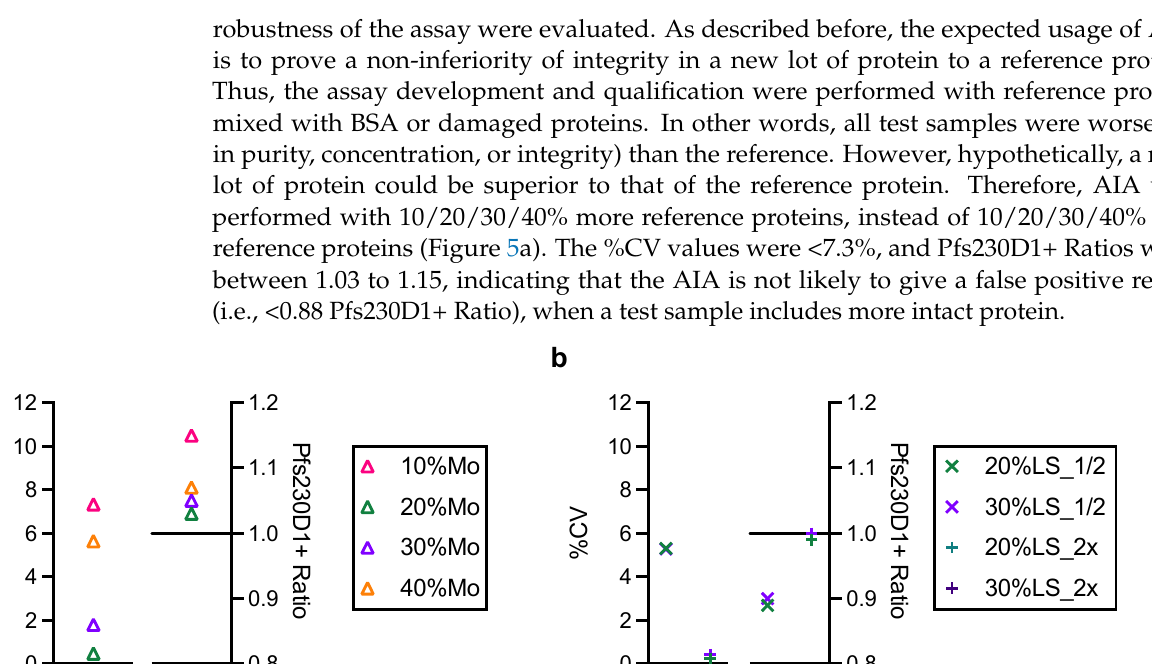
Figure 5. Robustness of assay. ( a ) AIA was performed with 10%, 20%, 30% or 40% more reference Pfs230D1+ proteins (10%Mo, 20%Mo, 30%Mo or 40%Mo, respectively) in test wells. Left-side panel shows %CV in triplicate wells and right-side panel for Pfs230D1+ Ratio. ( b ) AIA was performed with half (20%LS_1/2 or 30%LS_1/2) or double (20%LS_2x or 30%LS_2x) concentration of H18-HRP mAb using 20%LS and 30%LS samples with BSA. %CV for 20%LS_1/2 and 30%LS_1/2 were both 5.3, thus only a single symbol is seen in Figure 5b.